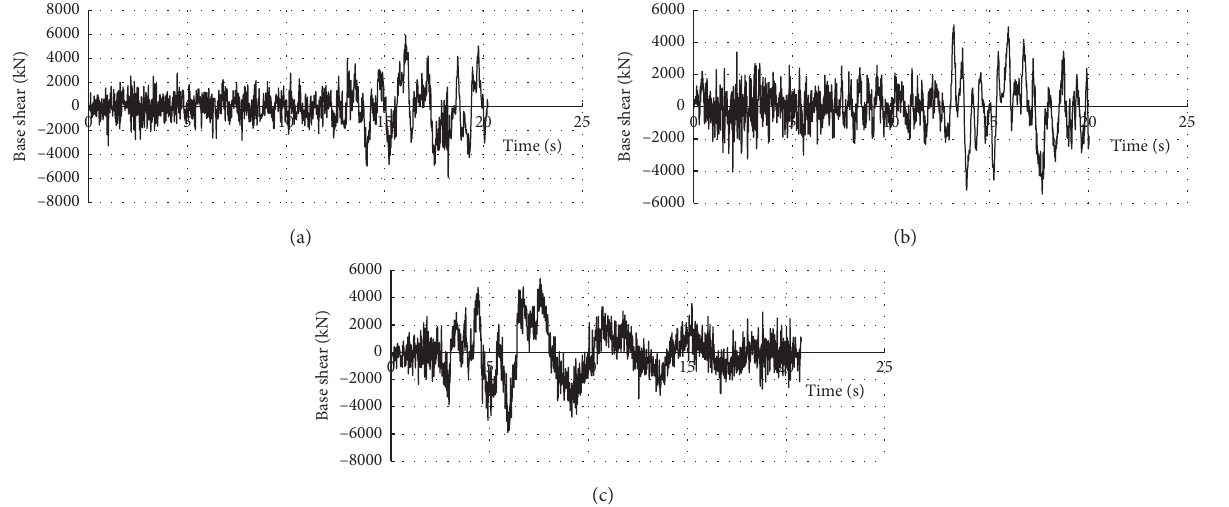
Figure 17: Elastic-plastic base shear-time history curve of structures. (a) TR1-X. (b) TR2-X. (c)